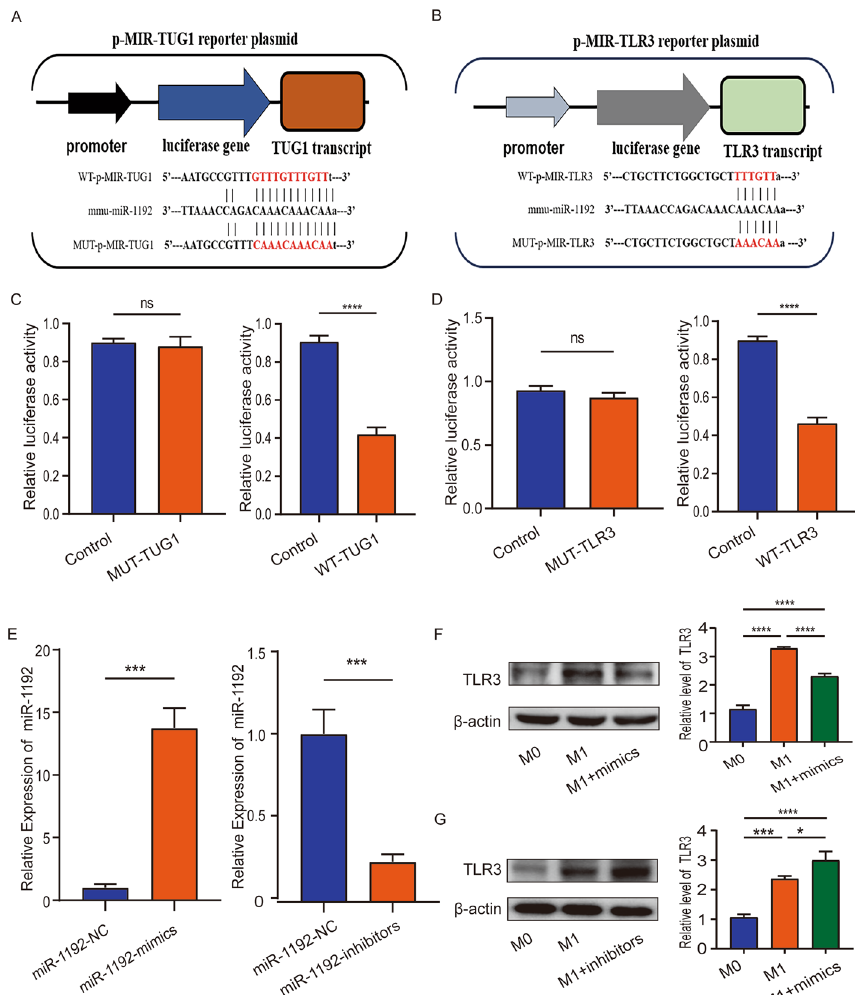
Fig. 5 TUG1 and TLR3 are direct targets of miR-1192. A The binding sites of miR-1192 and TUG1 were predicted by starBase database. B The binding sites of miR-1192 and TLR3 were predicted by starBase database. C , D miR-1192-mimics could inhibit the luciferase activity of WT-TUG1 and WT-TLR3, but had no effect on the luciferase activity of MUT-TUG1 and MUT-TLR3. E RT-PCR was used to detect the transfection efficiency of miR-1192 mimics and inhibitors. F , G Western blotting was used to detect the expression level of TLR3 after transfection of miR-1192 mimics and inhibitors. n 3 per group. * P < 0.05, *** P < 0.001, = **** P < 0.0001. ns not